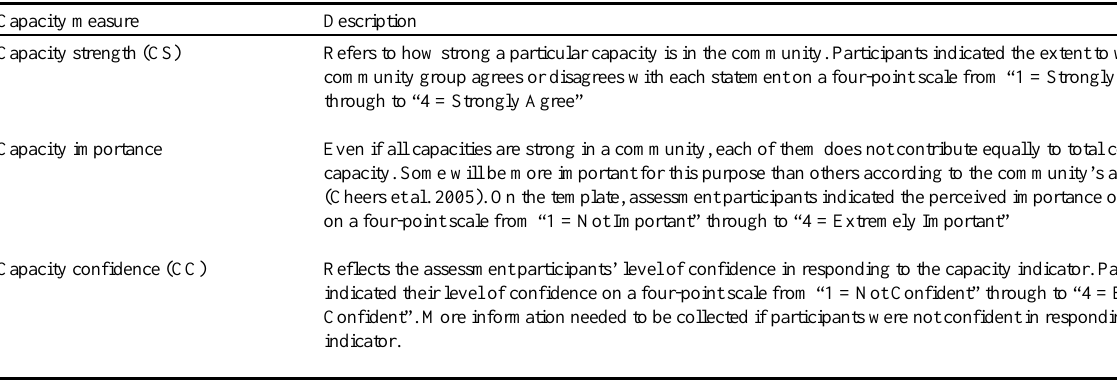
Table 3. The measurement of capacity strength, importance, and